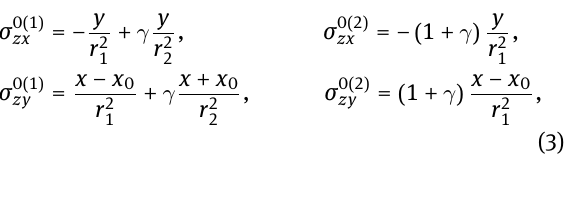
As indicated earlier, the zx -component of the classi- cal stress field should be continuous on x = 0, while